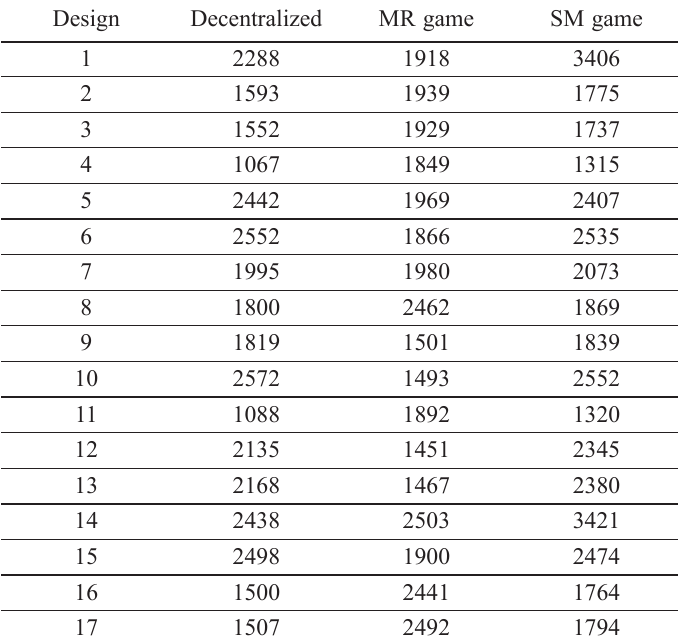
Table 7. The overall profit of the supply chain